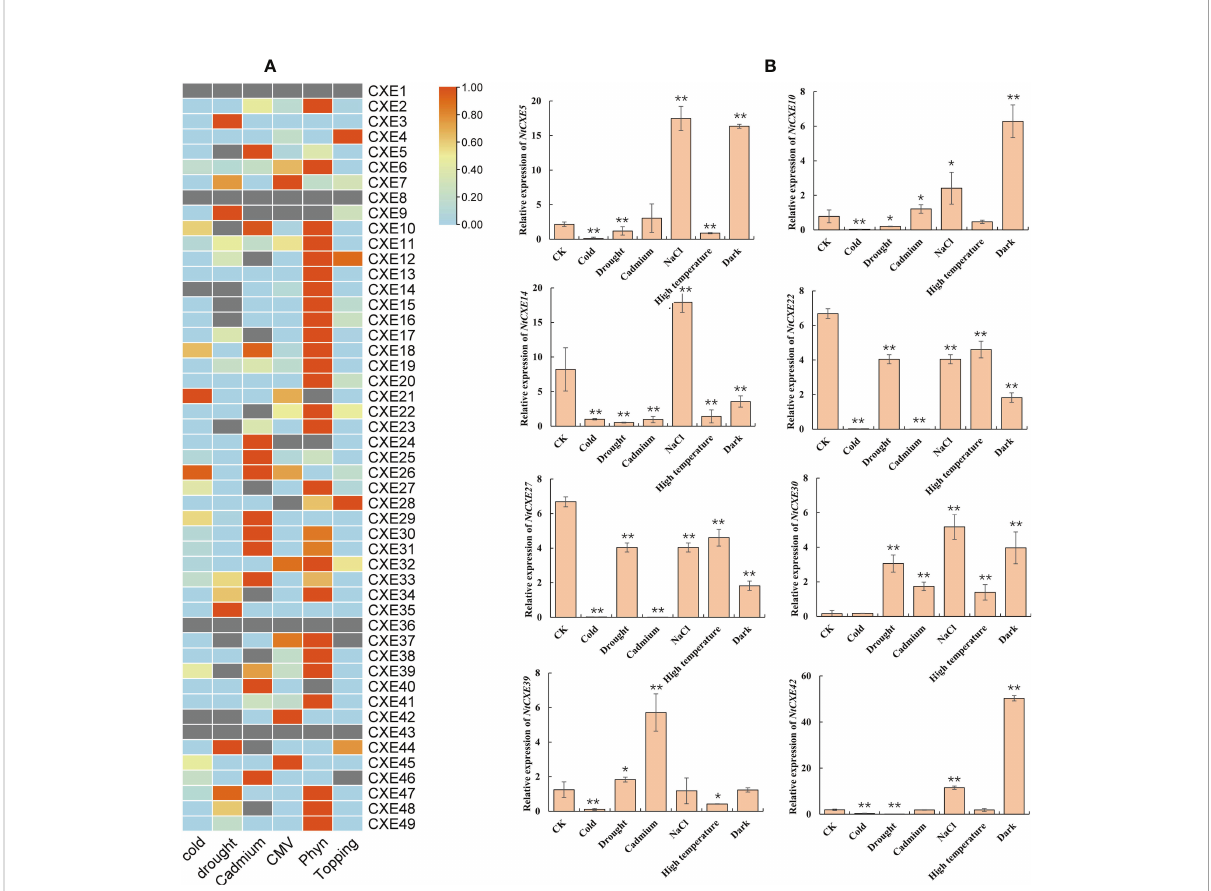
FIGURE 6 Analysis of tobacco NtCXE genes under various stress states. (A) Expression pro fi les of all NtCXE genes under cold, cadmium, topping, P. nicotiana infection, drought, and cucumber mosaic virus stresses, compared to the control treatment. Heat maps were drawn by TBtools using FPKM mean values, scaled by rows. Color represents the gene expression levels (orange, high expression level; and blue, low expression level). (B) qRT-PCR quantitative analysis of NtCXE5 , NtCXE10, NtCXE14, NtCXE22, NtCXE27, NtCXE30, NtCXE39, NtCXE42 in response to NaCl, cold, cadmium, drought, high temperature, cold, darkness stressors. Data are presented as means ± SDs (n = 3). *P < 0.05, **P < 0.01 (signi fi cant difference between the stress treatment and control, based on Student ’ s